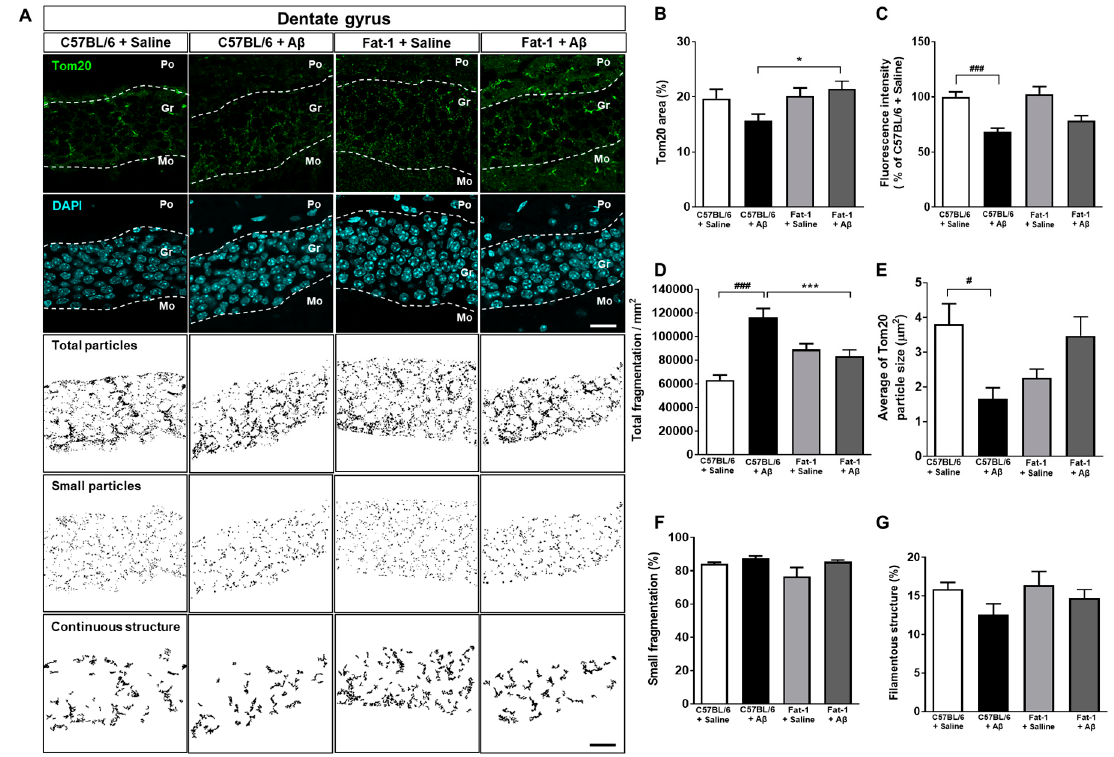
Figure 1. Effects of endogenous elevation of omega-3 PUFAs on altered mitochondrial dynamics demonstrated by A β -stereotaxic injection in fat-1 mice. ( A ) Immunofluorescence staining against Tom20 was conducted to examine the mitochondrial dynamics in the dentate gyrus of the hippocampus (scale bar = 20 μ m) [8,31]. ( B ) Quantification of the Tom20-positive area plotted as a percentage. ( C ) Quantification of Tom20 fluorescence intensity was normalized to that observed in saline-injected C57BL/6 mice. Total fragmentation ( D ), average Tom20 particle size ( E ), small fragmentation ( F ), and filamentous structures ( G ) were quantified by classifying the immuno-positive area of Tom20 according to the mitochondrial structure sizes, to demonstrate the fusion and fission of mitochondria. Data are presented as mean ± SEM (30–36 images/5–6 mice). # p < 0.05 and ### p < 0.001: C57BL/6 + Saline versus C57BL/6 + A β . * p < 0.05 and *** p < 0.001: C57BL/6 + A β versus Fat-1 + A β . Po: polymorph layer, Gr: granular layer, Mo: molecular layer.